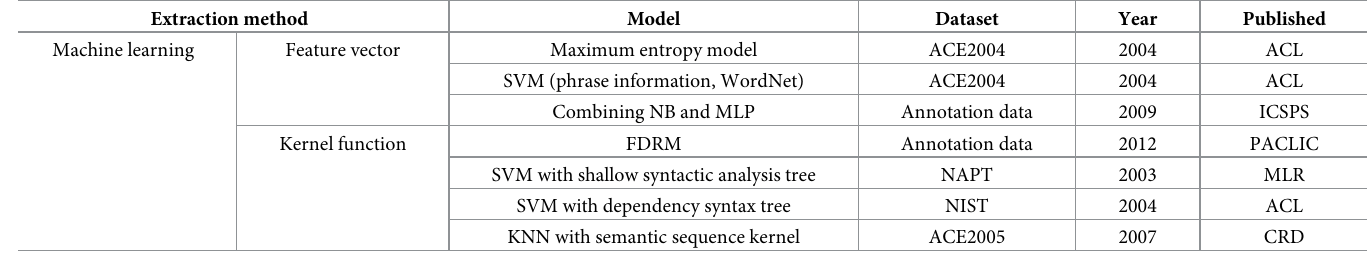
Table 2. The different models and datasets based on machine